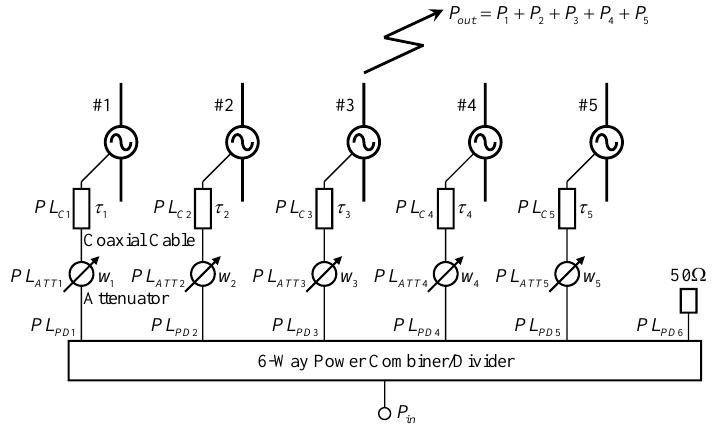
Figure 15. Configuration of a beamforming network.